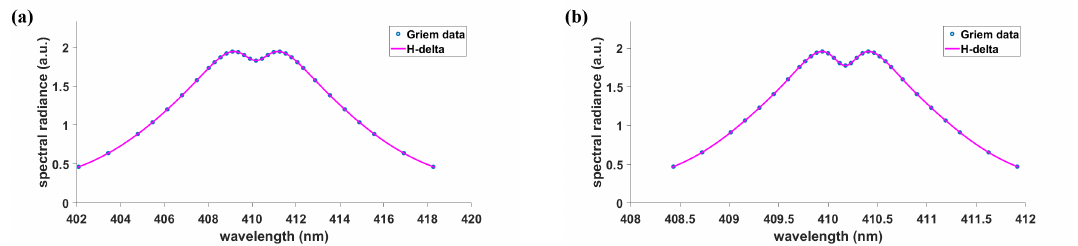
Figure 5. Line shapes of Balmer H δ at a temperature of 20 kK [21]. ( a ) N e = 1 × 10 17 cm − 3 , FWHM:10nm, PS: 2.0 nm. ( b ) N e = 0.1 × 10 17 cm − 3 , FWHM: 2.2 nm, PS: 0.5